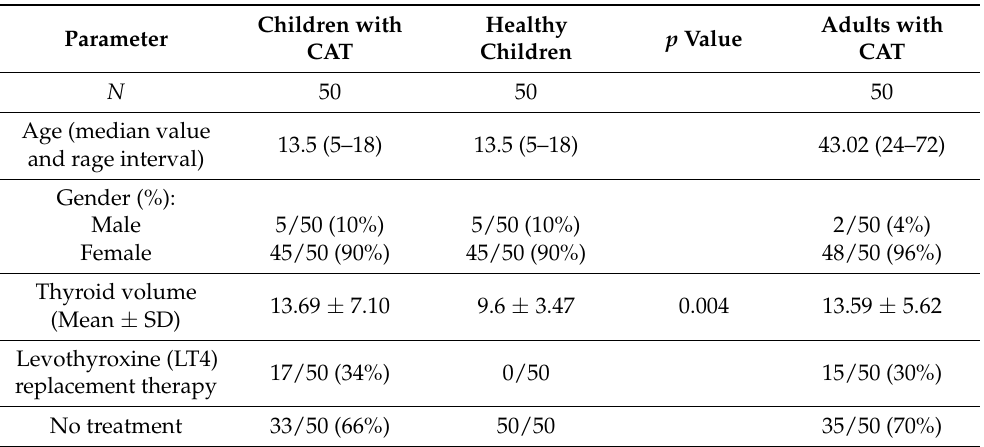
Table 1. Main characteristics of the study group ( N —number of